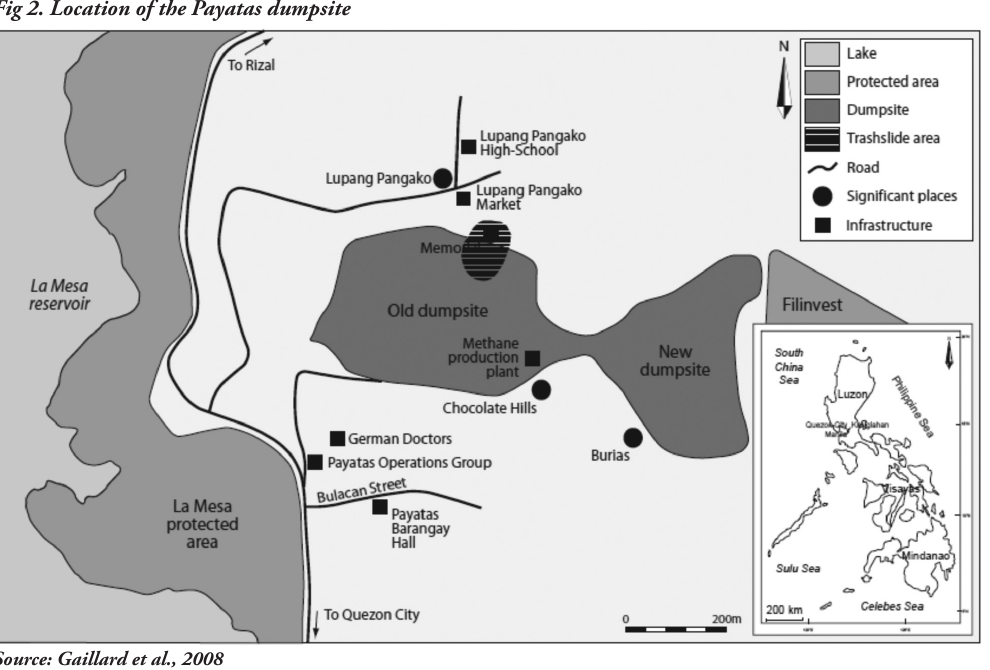
Fig 2. Location of the Payatas